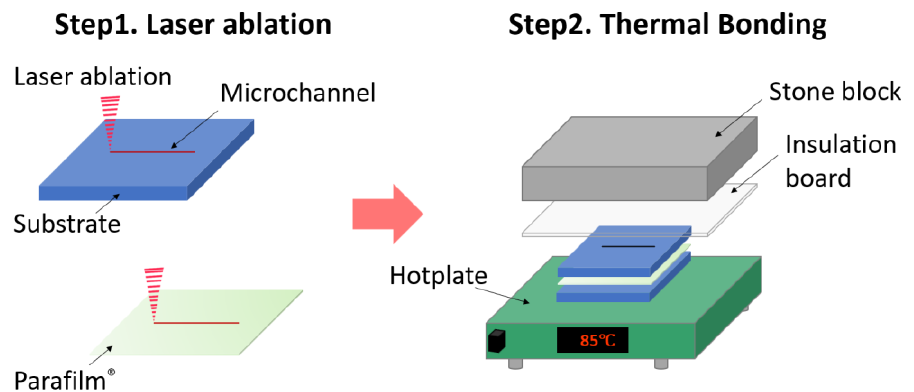
Figure 1. Fabrication process flow of the Parafilm ® -based laser ablation and thermal bonding (PbLT) fabrication method. Parafilm ® and different substrates were cut to desired patterns (Step 1). Then, they were aligned and assembled manually. Followed by thermal bonding (Step 2), the assembly was placed on a hotplate for constant heating. An insulation board and stone block were superposed for uniform static pressure.